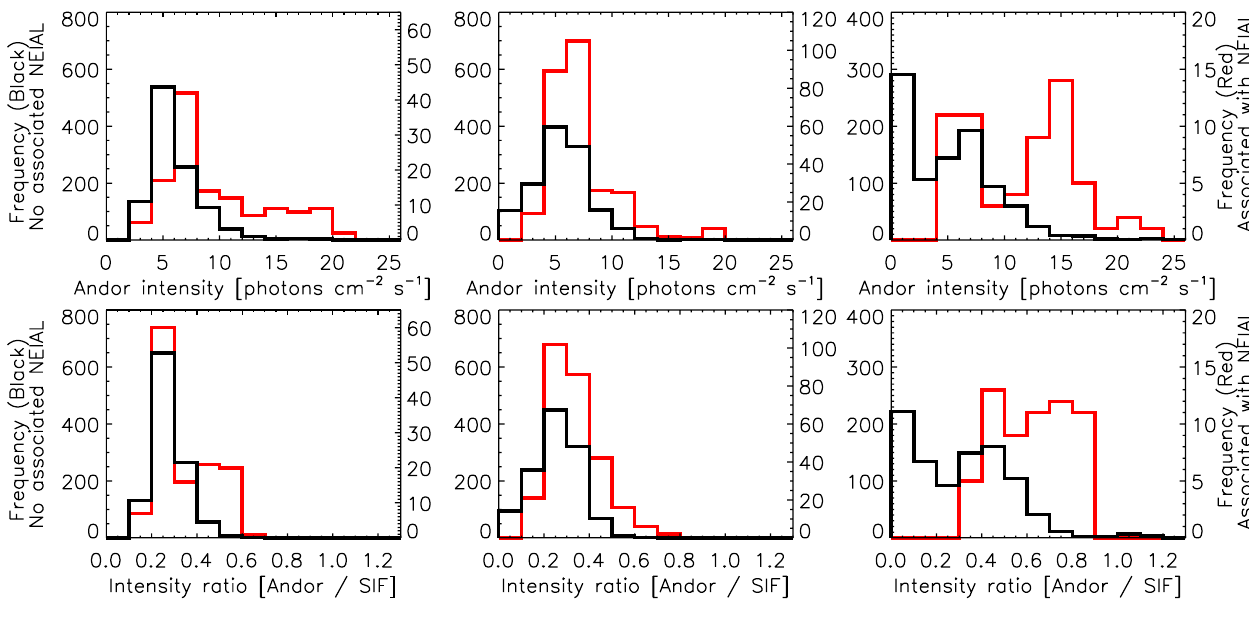
Fig. 7. Andor intensities and Andor/SIF ratios separated into data points associated with a NEIAL (shown in red), and those where no NEIAL was recorded, (shown in black). The histograms shown are for 15min intervals of data, starting, from left to right at 08:45UT, 09:00UT and 09:15UT,